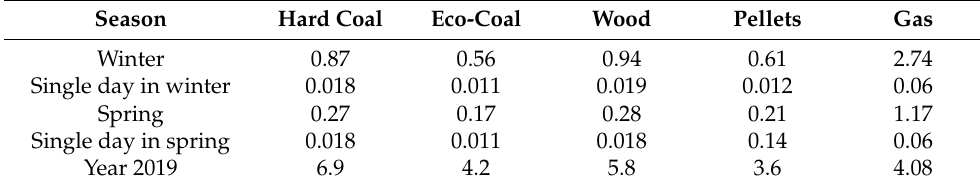
Table 2. Average fuel consumption (Mg) in the single village households during periods of sampling. Season Hard Coal Eco-Coal Wood Pellets Winter Single day in winter